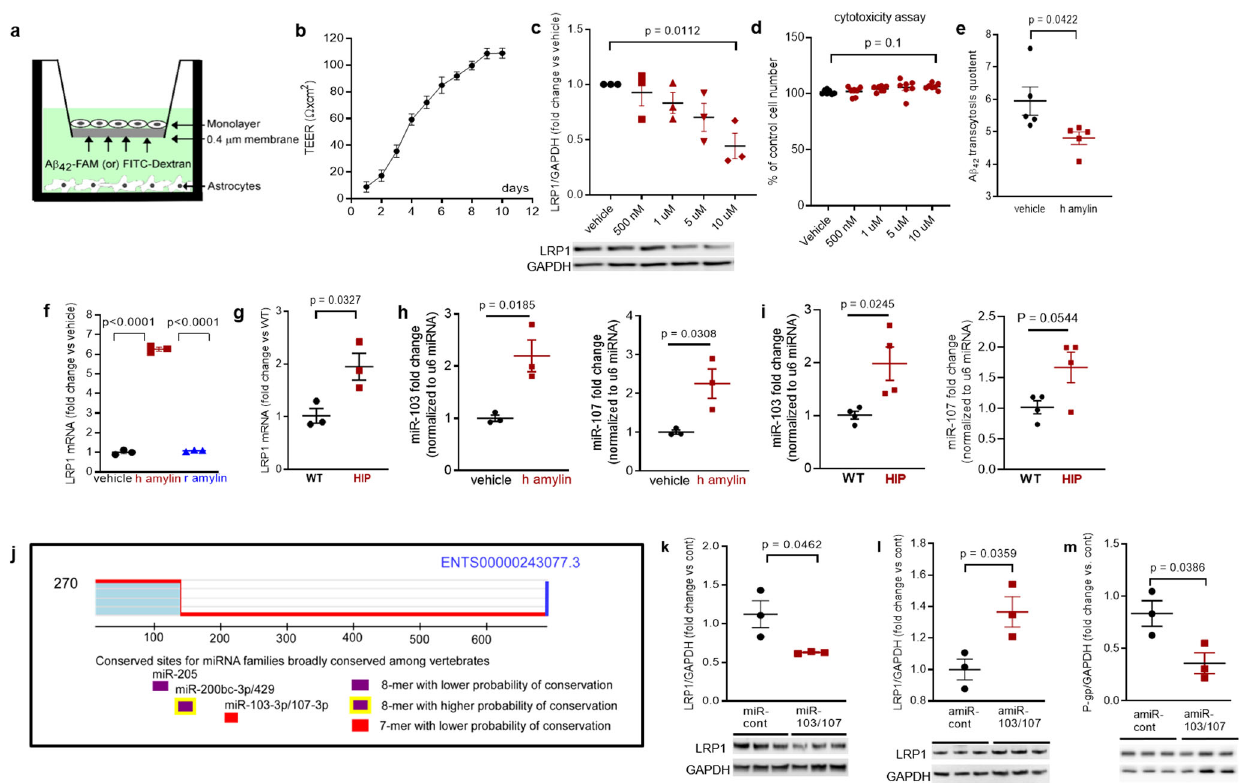
Fig. 6 In vitro test of amylin-induced impairment of A β ef fl ux across the BBB. a Cartoon representation of the in vitro BBB model (ECs monolayer - luminal chamber; astrocytes - abluminal chamber) used in A β transcytosis experiments. b Transendothelial electrical resistance ( TEER ) in EC monolayers ( n = 20 preparations) as a function of days in culture. c Representative Western blot and densitometry quanti fi cation of LRP1 in lysates from primary rat brain microvascular vascular ECs treated with vehicle or various concentrations of human amylin (500 nM, 1 µ M, 5 µ M, and 10 µ M) for 24 h ( n = 3 preparations/test). d Percent cell viability from the MTS assay in ECs treated with amyloid-forming human amylin (500 nM, 1 µ M, 5 µ M, and 10 µ M) or vehicle, for 24 h. e The A β 42 transcytosis quotient (TQ) across the in vitro BBB, in vehicle- and human amylin-treated EC monolayers. f LRP1 mRNA levels (fold difference using 2 − ΔΔ Ct method) measured with qRT-PCR in lysates from ECs treated with vehicle, human amylin or rat amylin. g LRP1 mRNA levels measured by qRT-PCR in brain capillary lysates from same rats as in Fig. 5h. h , i miRNA (miR)-103 and miR-107 expression levels measured by qRT-PCR in lysates from ECs treated with vehicle or human amylin (same as in Fig. 5h), and in brain capillary lysates from same rats as in Fig. 5h. j TargetScan schematic showing consensus regions for miR-205 , miR200bc-3p/429 , and miR-103 and miR-107 . Western blot analyses of LRP1 from miRNA (miR) 103 and miR-107 treated ECs compared to miR-control ( n = 3 preparations/group) ( k ), as well as of LRP1 ( l ) and P-gp ( m ) from antagomir (amiR) 103 and amiR-107 treated ECs compared to amiR-control treated cells ( n = 3 preparations/group). Data are mean ± SEM. one-way ANOVA with Dunnett ’ s post hoc (F). unpaired t test for the other